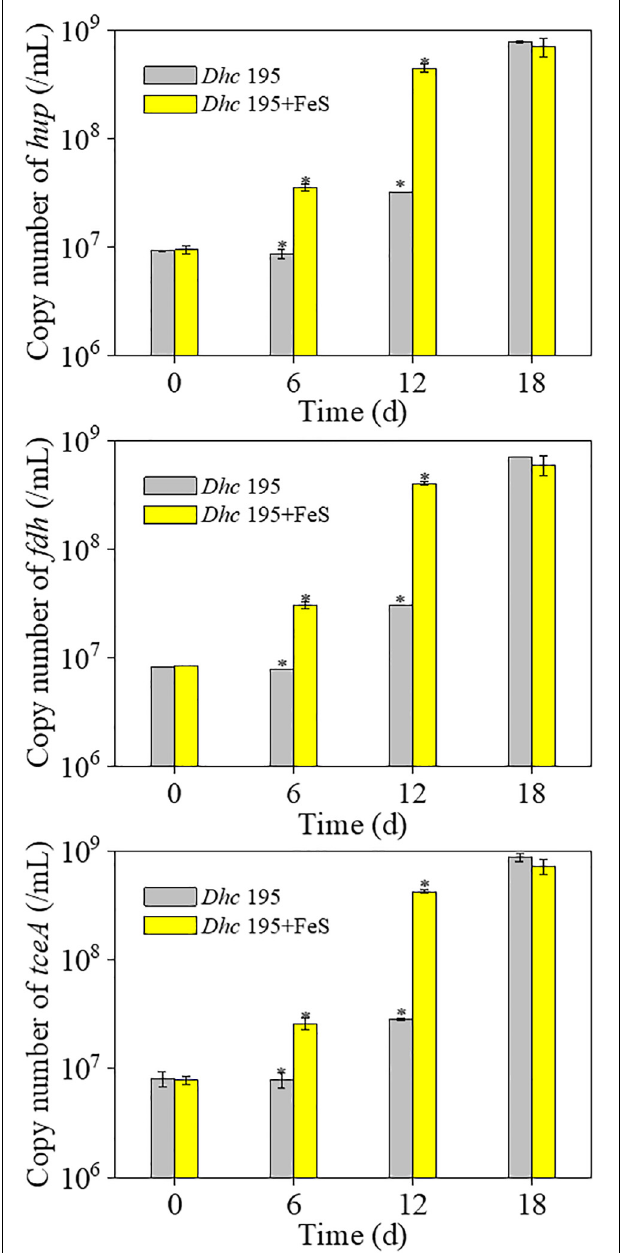
FIGURE 4 | The copy number of three key genes of Dhe 195 with and without FeS ( ∗ means significant difference, p -value < 0.05).